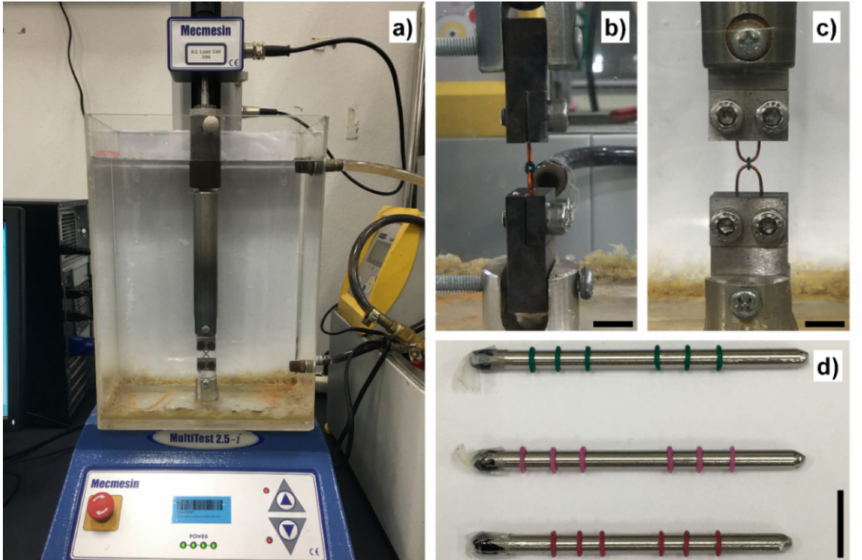
Figure 2. ( a ) The universal tensile testing setup in this study. ( b ) Side-view image of the sample holder. ( c ) Front-view image of the sample holder. ( d ) The samples during uniform stretching experiment. Brand B samples fractured upon being uniformly stretched. Scale bars are approximately 10